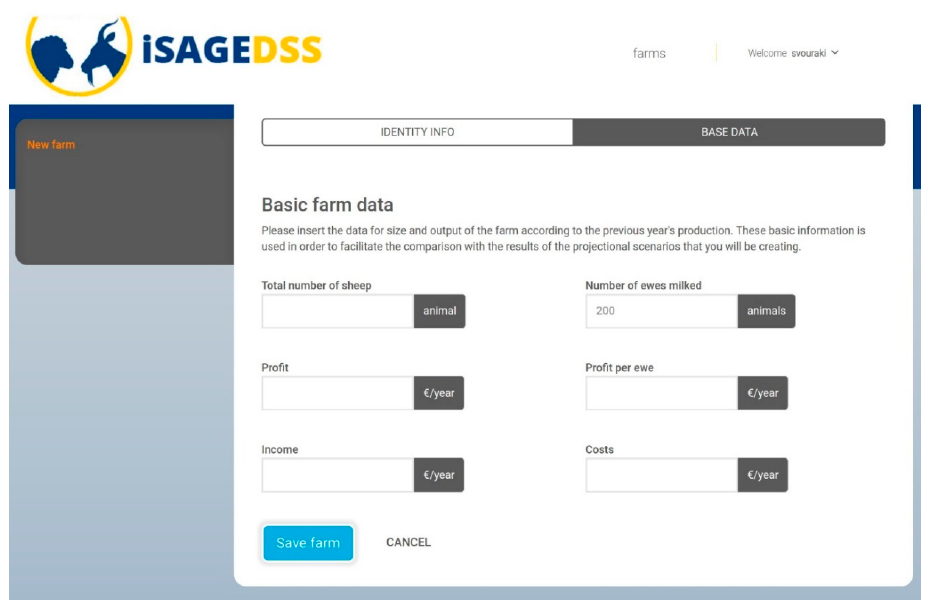
Figure 3. Creation of farm—farm basic data; users provide useful information for the recent production period (costs refer to the variable costs of the farm).